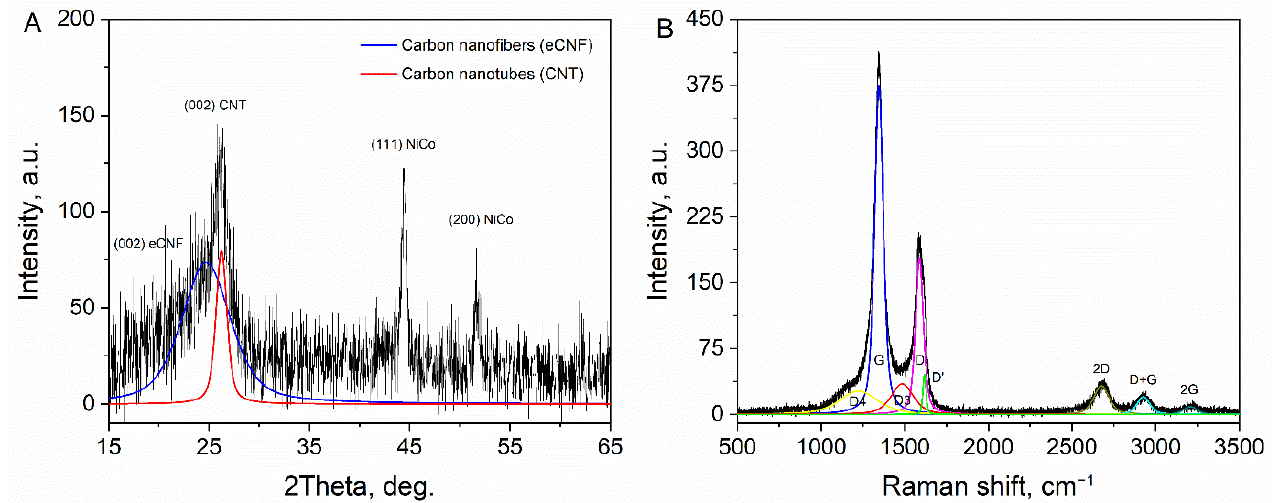
( A ) GIXRD diffraction pattern and ( B ) Raman spectra of hierarchical nanofibers, eCNF/CNT/NiCo.